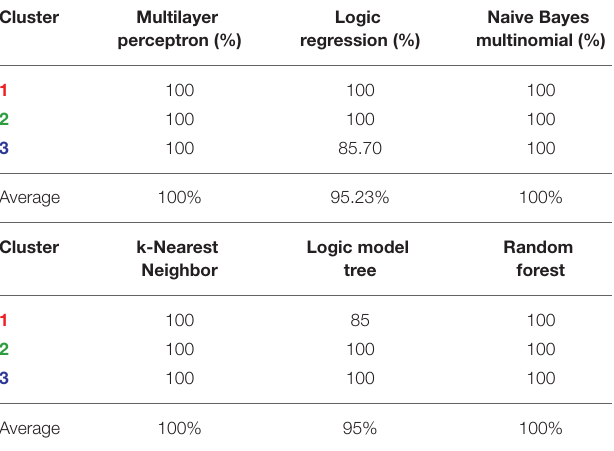
TABLE 3 | Classification accuracy for top 15 genes using six different classification techniques.